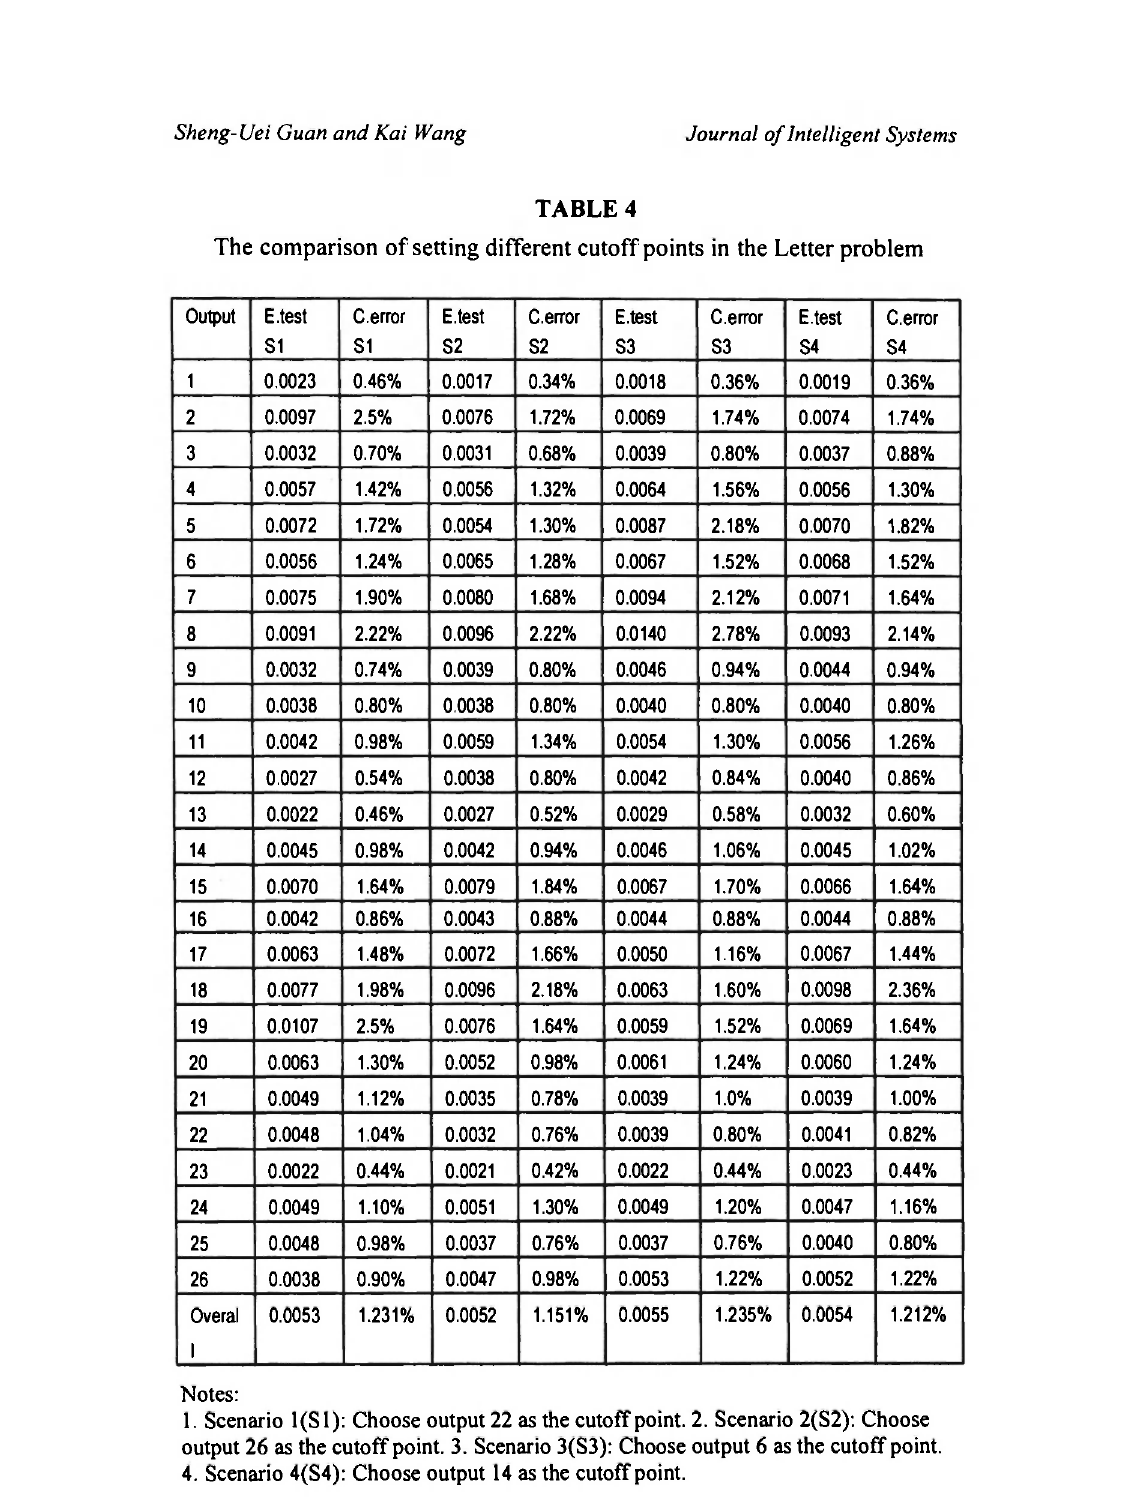
The comparison of setting different cutoff points in the Letter